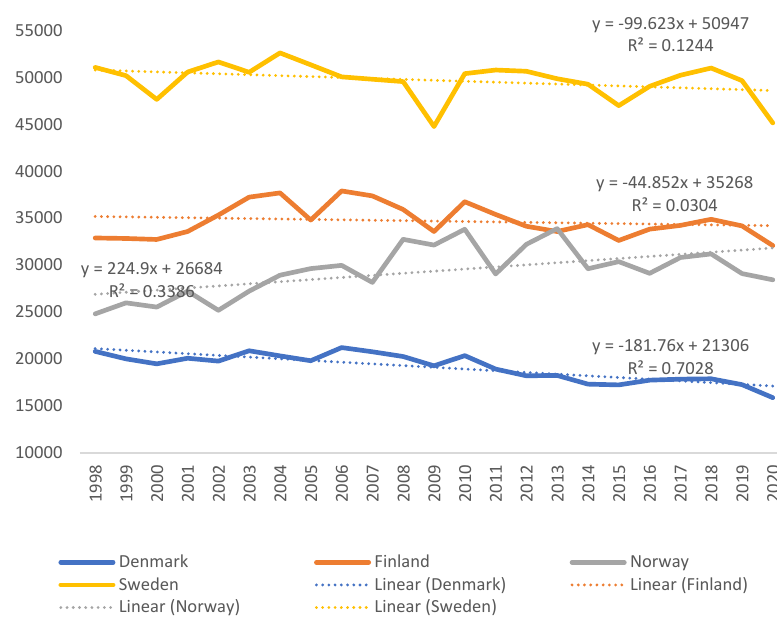
Figure 2. Energy consumption (thousand tons oil equivalent. Source: Nordic Statistics database [31].